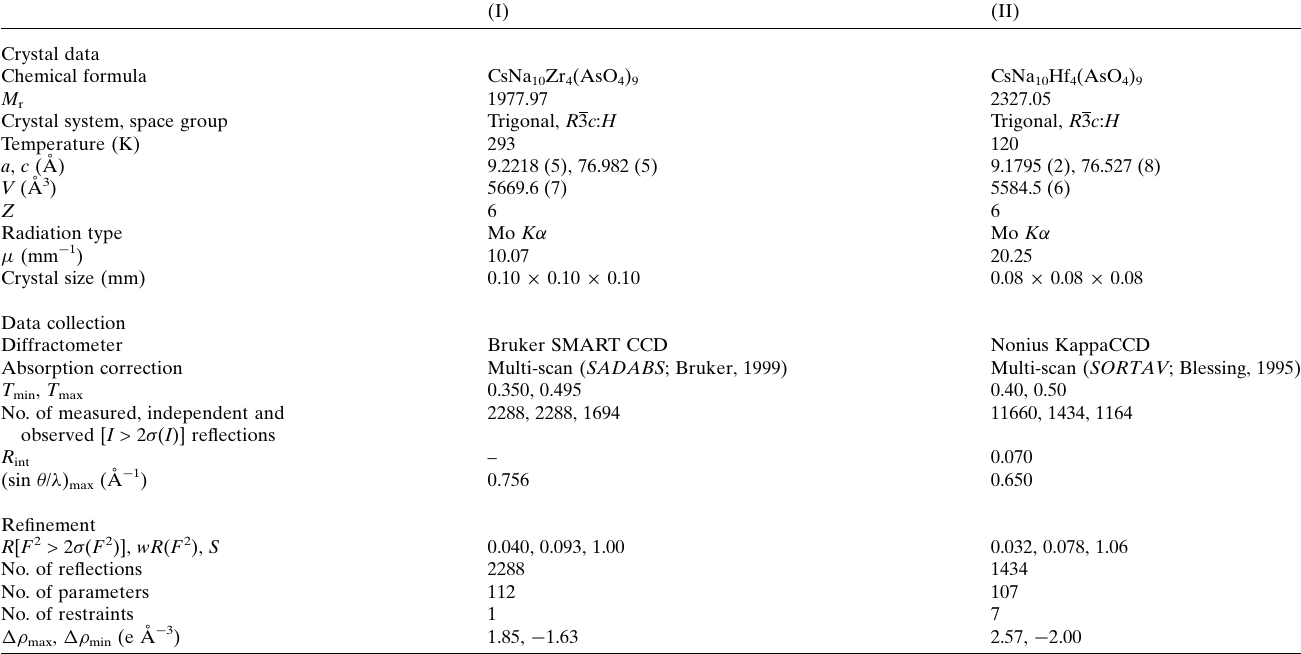
Table 1 Experimental details.